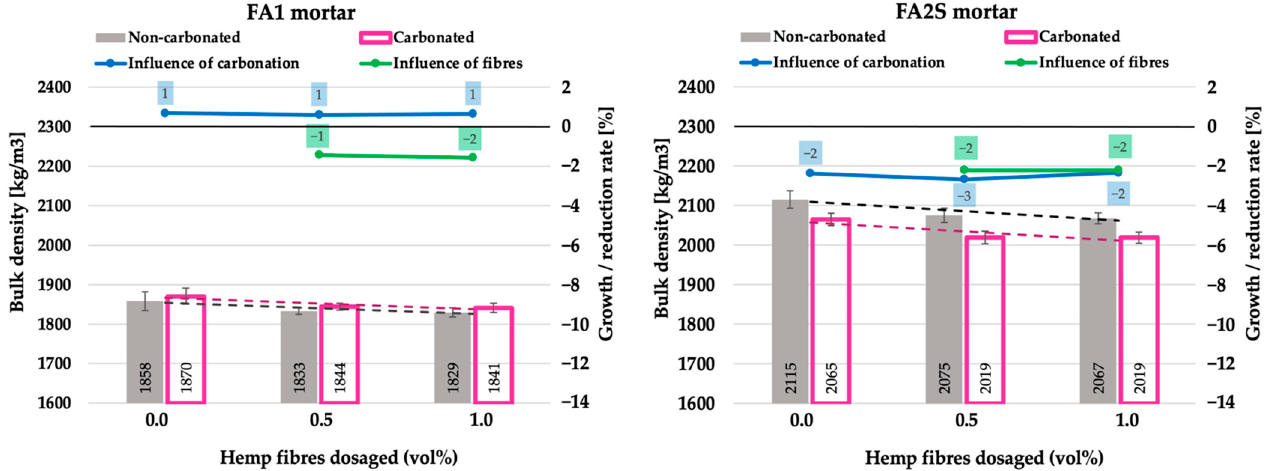
Figure 2. Density of fly-ash-based (FA1) and fly-ash-and-slag-based (FA2S) mortars prior to [26] and after accelerated carbonation.